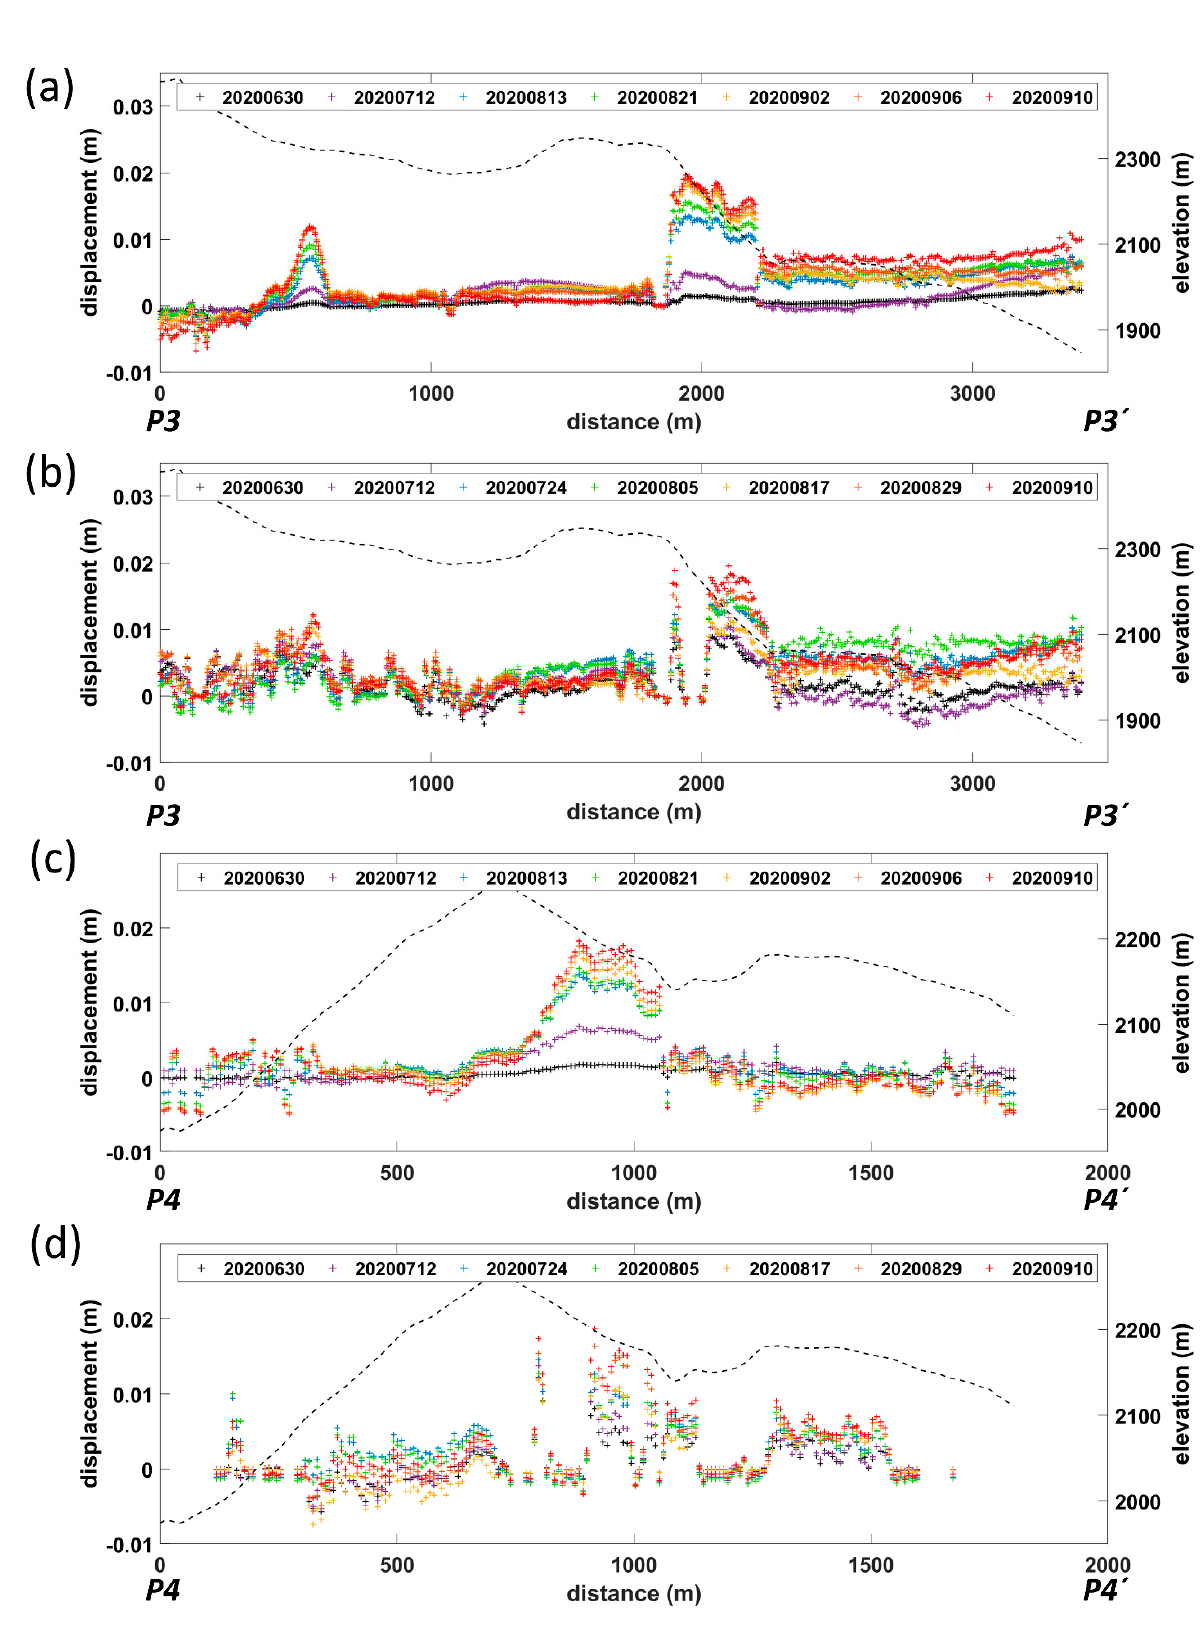
Figure 9. LOS time-series analysis of Site 6 displacement profiles. ( a ) RCM P3-P3 (cid:48) profile, ( b ) Sentinel-1 P3-P3 (cid:48) profile, ( c ) RCM P4-P4 (cid:48) profile, ( d ) Sentinel-1 P4-P4 (cid:48) profile. The black dashed lines represent elevations along the